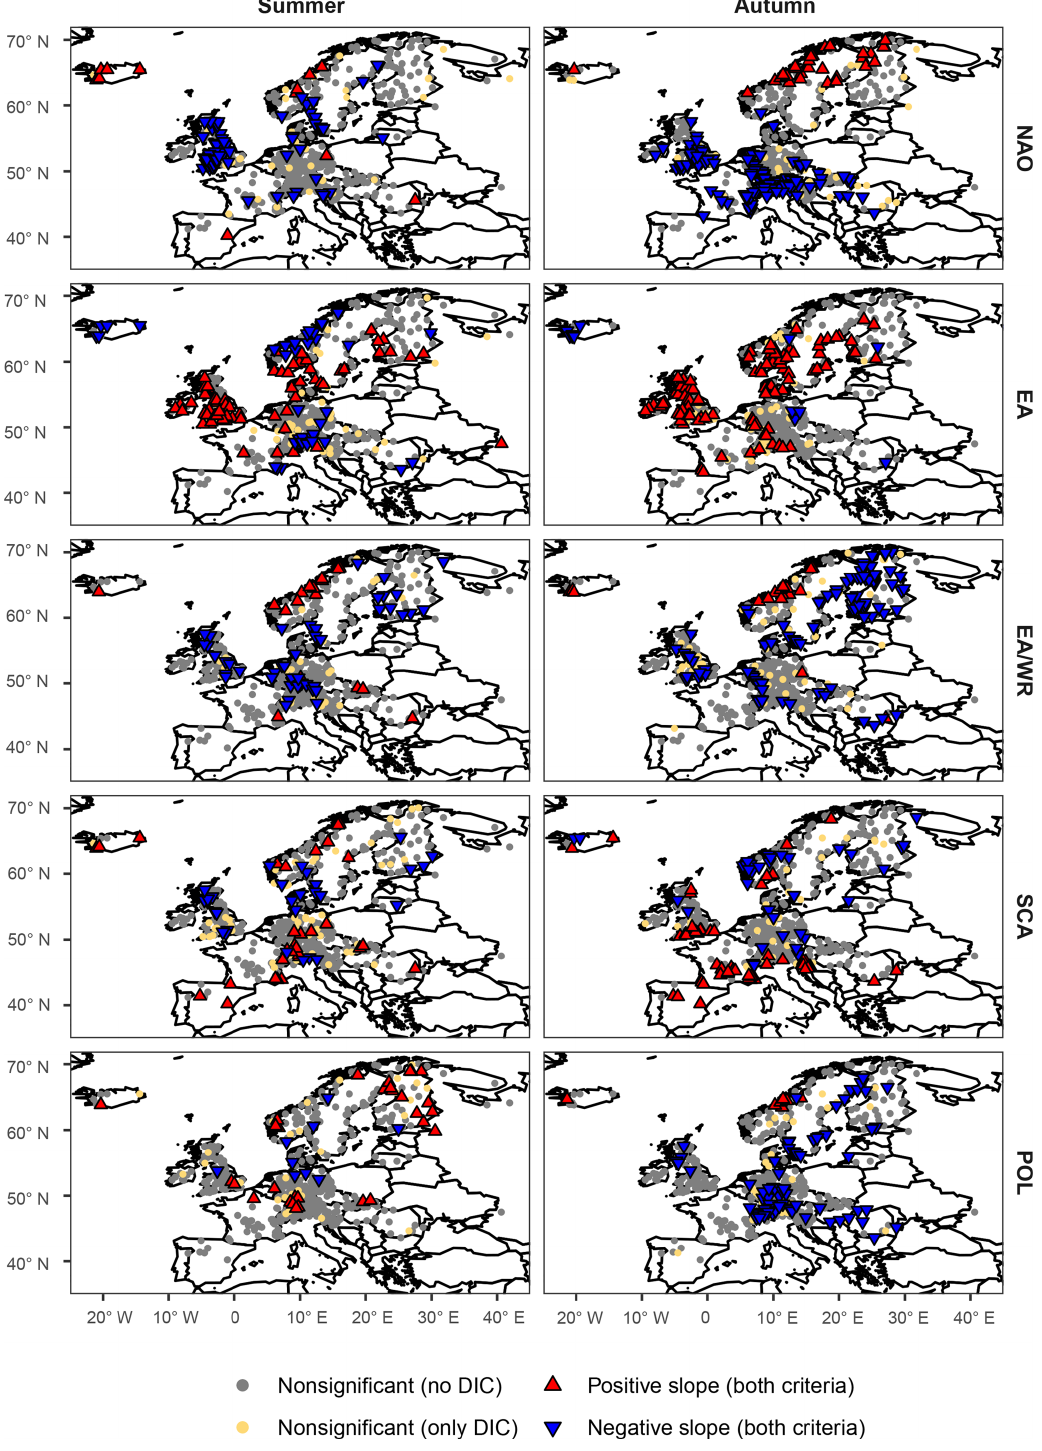
Figure 2. Same as Fig. 1 but for the summer and autumn